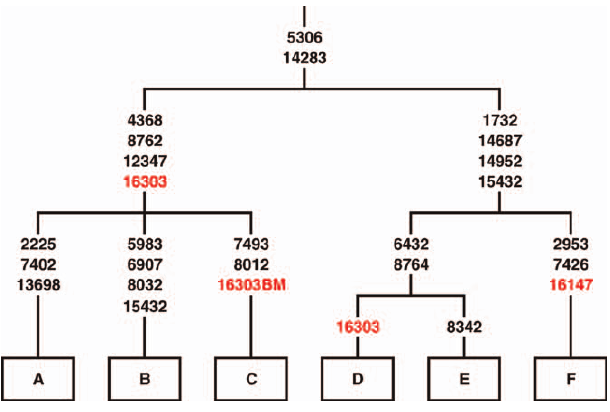
Figure 1. HVS-I Identity by Descent or by State A theoretically evolving tree is presented. Coding-region polymorphisms are in black. HVS-I polymorphisms are in red. Samples A and B share HVS- I haplotype 16303 by descent. Samples A and D or B and D share HVS-I haplotype 16303 by state and as a result of homoplasy. Samples C and E are identical by state as a result of a back mutation in position 16303 in sample C as marked by the ‘‘ BM ’’